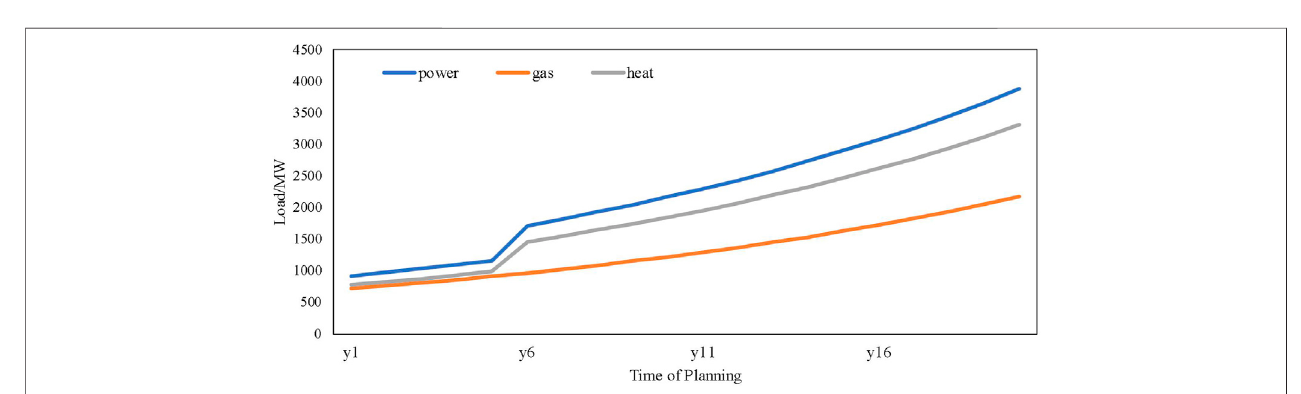
FIGURE 5 | Load curve considering special